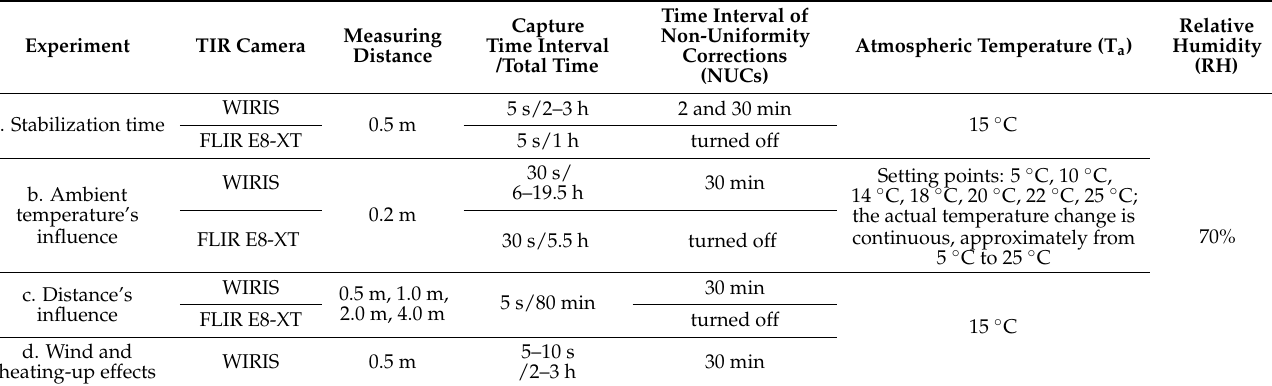
Figure 1. General introduction of the experimental design. Table 2. Overview of environmental parameter settings related to sets of